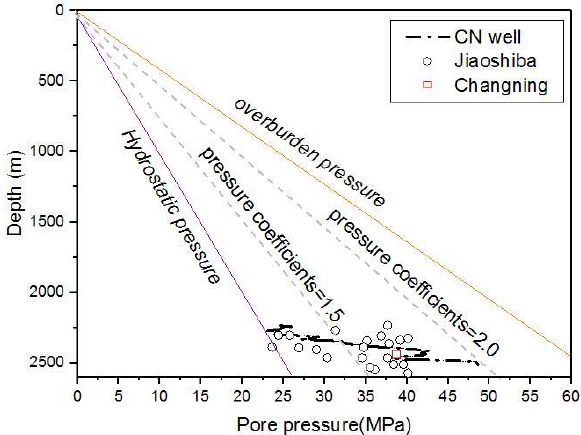
3 w–S 1 l shales for well CN. Minerals 2019 , 9 , x FOR PEER REVIEW